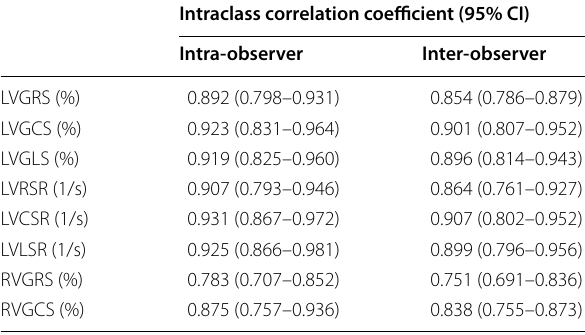
Table 5 intra-observer and inter-observer reproducibility of LV and RV strain and strain rate Intraclass correlation coefficient (95%